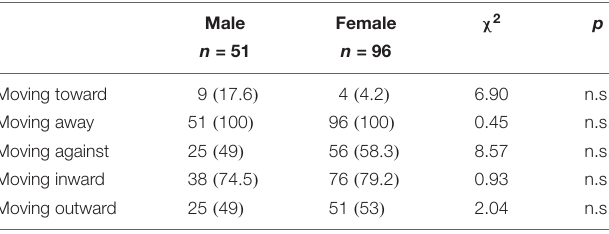
TABLE 5 | Typology of coping strategies used by male and female HCP victims of stalking and domestic violence ( N = 147).